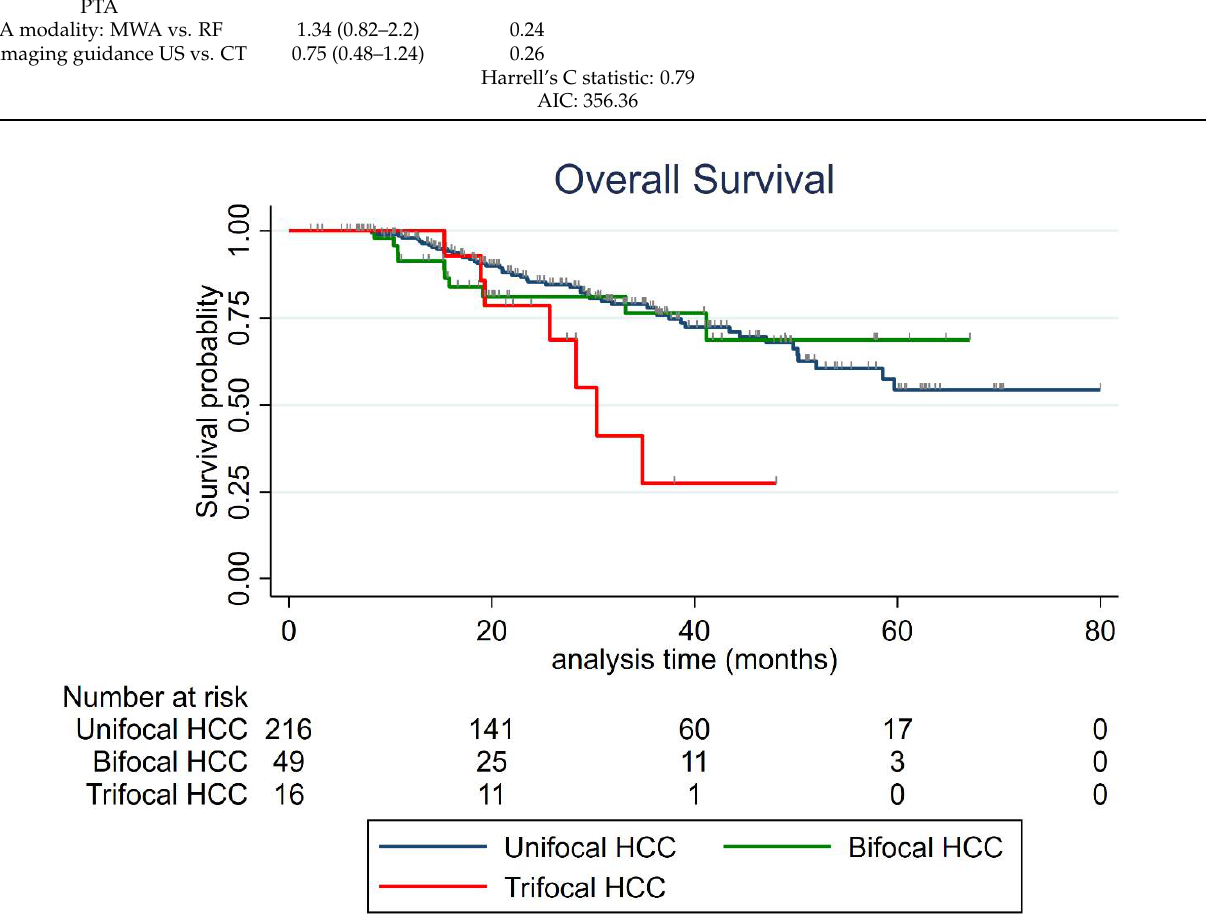
Figure 4. Overall survival according to the number of HCC nodules.